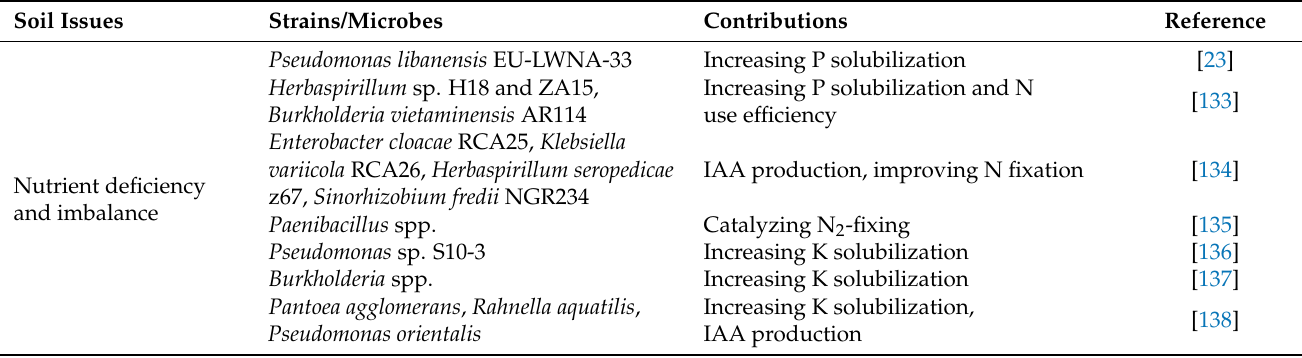
Table 1. Functional microorganisms and their contributions to soil remediation.